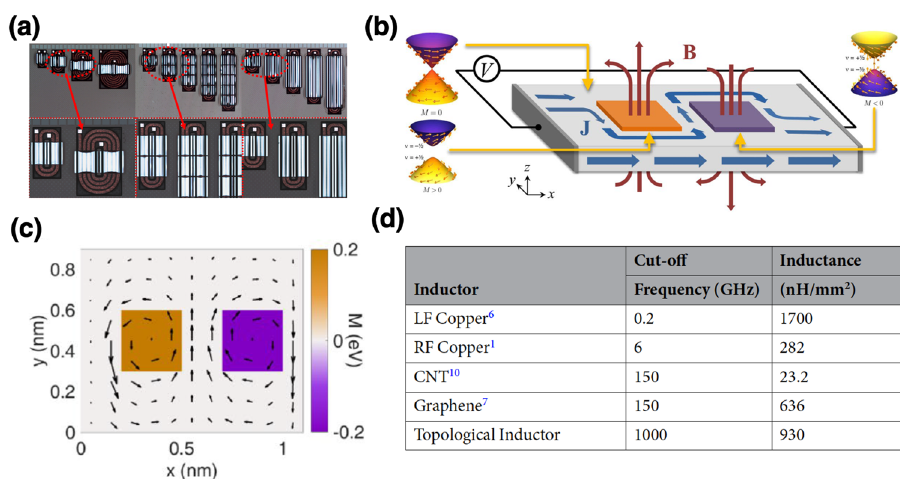
Fig. 7 Topological magneto-electric effect inductors. a Micrographs of Ni 45 Fe 55 inductor elements as fabricated by physical vapor deposition. Reprinted from ref. 76 , with the permission of AIP Publishing. b Theoretical schematic of a novel inductor structure that utilizes antiferromagnetically ordered ferromagnetic islands on the surface to induce magneto-electric responses and transduce energy 75 . c The current density on the surface of a topological inductor near the antiferromagnetically ordered islands showing the current forming a vortex 75 . d Table comparing various state-of-the-art inductor technologies illustrating the potential of topological materials in passive magnetic electronic devices. 75 . Reprinted by permission from ref. 75 , copyright